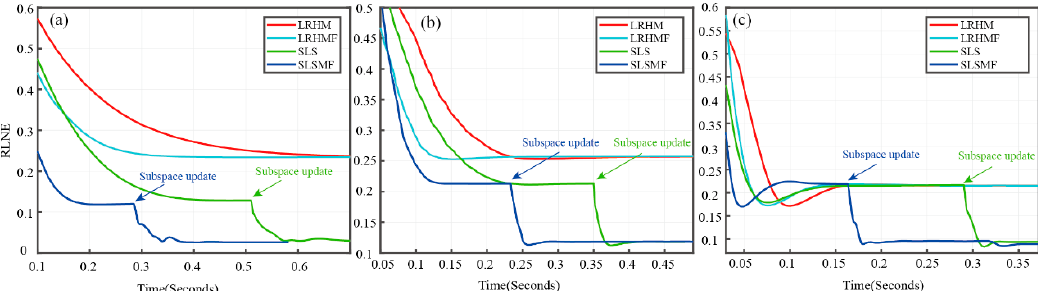
Figure 9. Peak intensity correlation between fully sampled spectrum and reconstructed spectra of the solid NMR. ( a – d ) are correlation plots of all peaks using LRHM, LRHMF, SLS, and SLSMF, respectively. ( e – h ) are correlation plots of low-intensity peak using LRHM, SLS, and SLSMF, respectively.